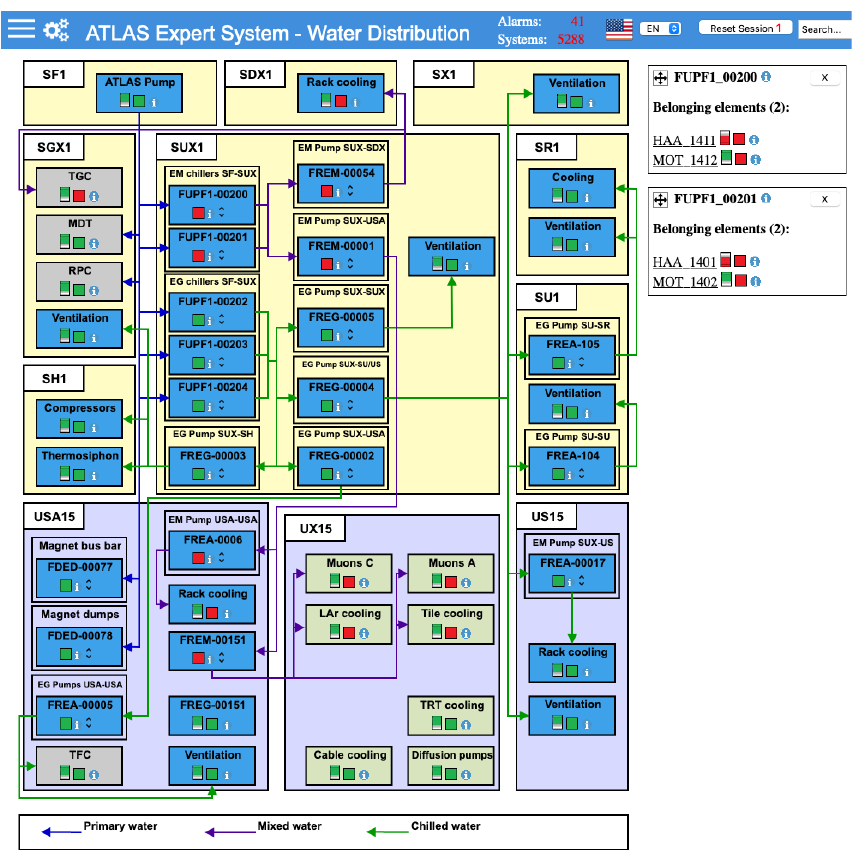
Figure 4. View of Expert System water distribution panel during simulation of annual maintenance of chilled